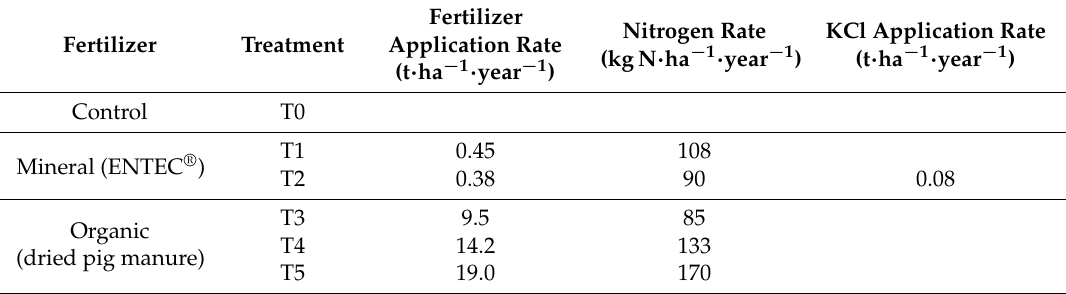
Table 1. Fertilizer and KCl application rates, and nitrogen rates for the treatments.